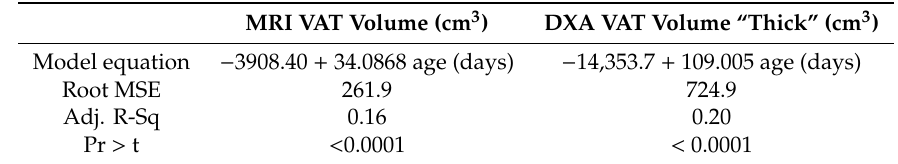
Table 5. Relationship between MRI VAT volume and DXA VAT volume in “thick” mode and the age of the